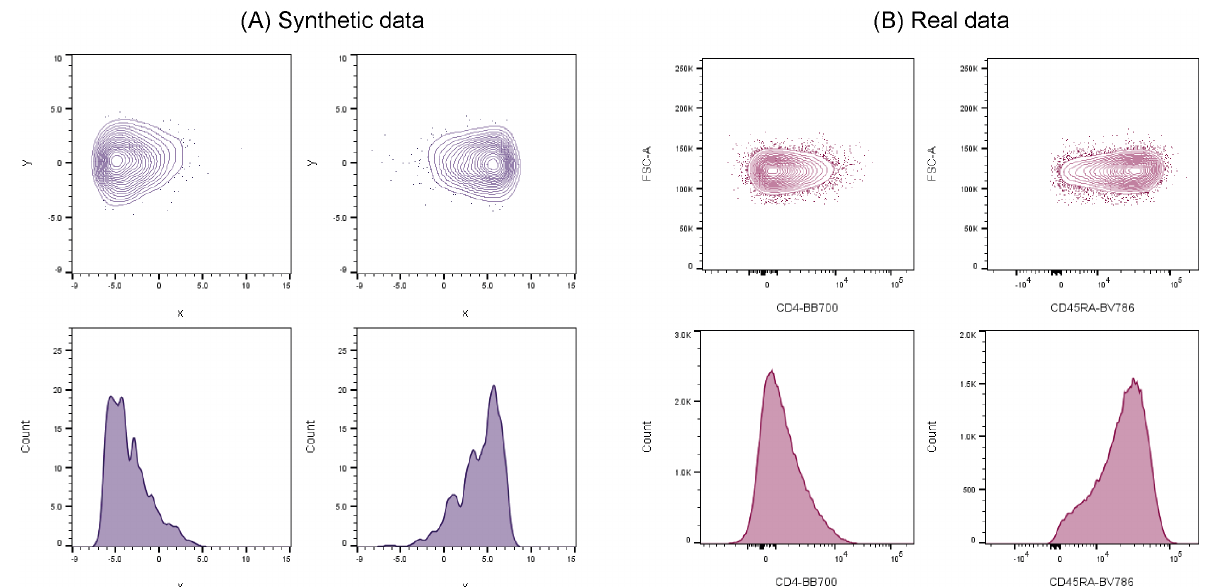
Figure 1. Inter-comparison between synthetic and real flow cytometry data showing clear similarities among cell distribution